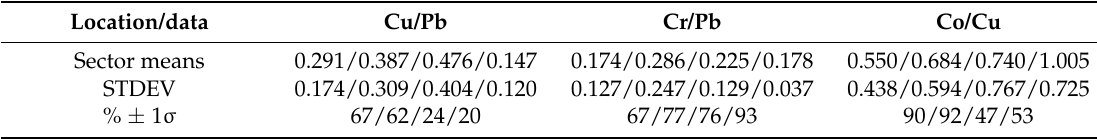
Table 8. Selected metal ratios for S, E, N and W